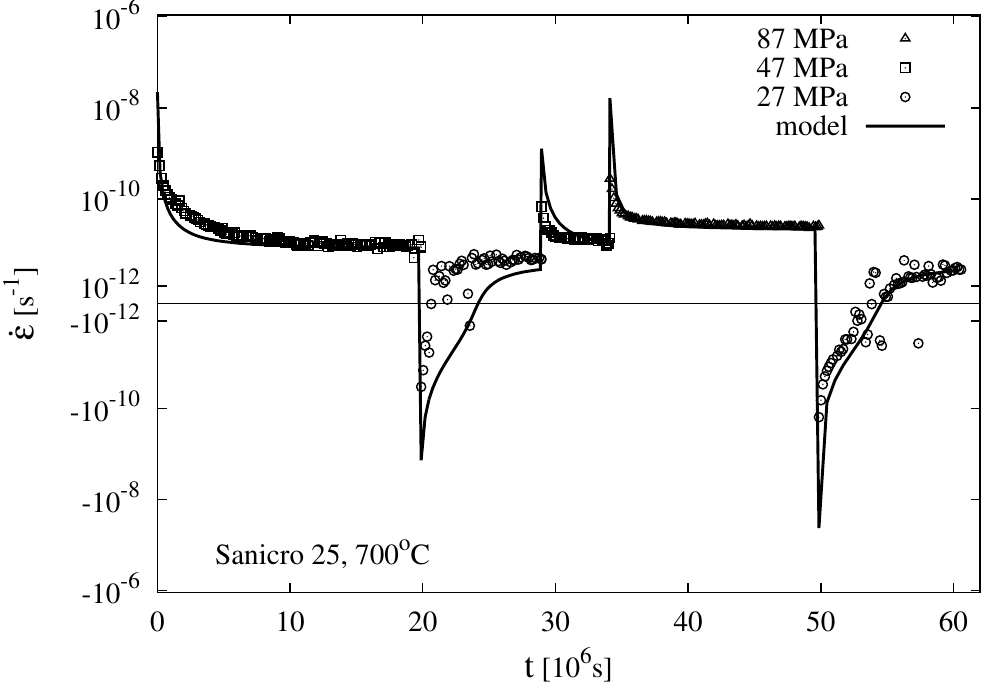
Figure 8. Creep rate dependence on time for Sanicro 25 at 700 ◦ C and stress changes (points) compared to model results (line).